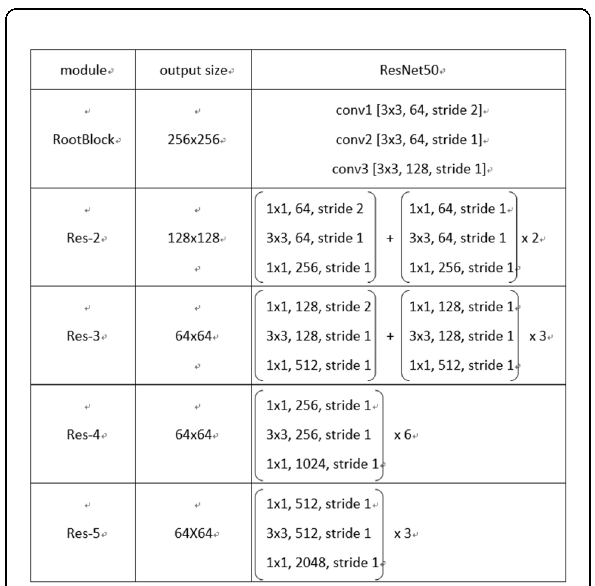
Fig. 4 The structure of ResNet50 network with the shape of “ 1x1, 64, stride 2 ” indicates that the size of the convolution kernel is 1 × 1, the number of the output feature maps is 64, and stride 2 indicates the convolution